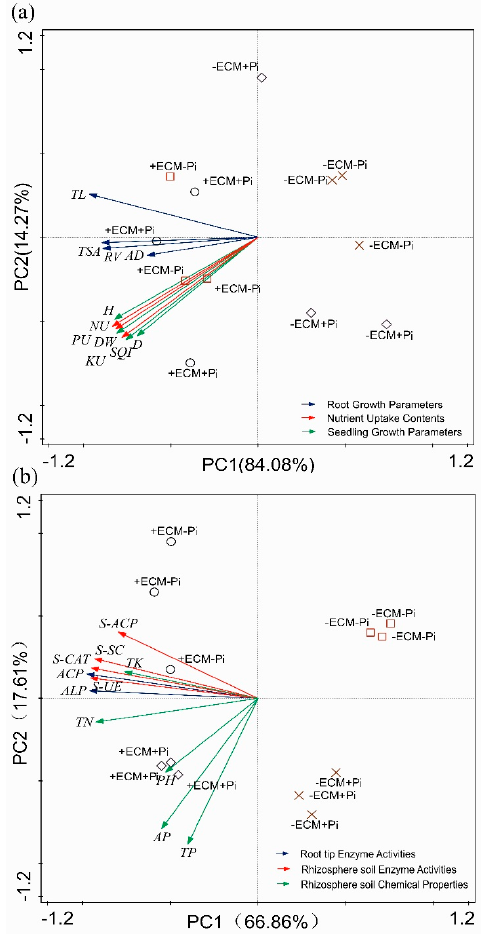
Figure 6. Principal component analysis (PCA) describing the responses of nutrient uptake, and root and seedling growth parameters ( a ), and the root tip enzyme activities, the rhizosphere soil enzyme activities, and chemical properties ( b ). -ECM-Pi: uninoculated and low Pi; -ECM+Pi: uninoculated and high Pi; +ECM-Pi: inoculated and low Pi; +ECM+Pi: inoculated and high Pi; H: height (cm); D: diameter (mm); DW: dry weight (g); SQI: seed quality index; TSA: root total surface area (cm 2 ); TL: root total length (cm); RV: root volume (cm 3 ); AD: root average diameter (mm); NU: whole plant (sum of roots, stems and leaves) N uptake (g ‧ plant − 1 ); PU: whole plant (sum of roots, stems and leaves) P uptake (g ‧ plant − 1 ); KU: whole plant (sum of roots, stems and leaves) K uptake (g ‧ plant − 1 ); ALP: root alkaline phosphatase (U ‧ g − 1 ); ACP: root acid phosphatase (U ‧ g − 1 ); S-ACP: soil acid phosphatase (U ‧ mg − 1 ); S-CAT: soil catalase activity (U ‧ g − 1 ); S-SC: soil sucrase activity (U ‧ g − 1 ); S-UE: soil urease activity (U ‧ g − 1 ); AP: available phosphorus (mg ‧ kg − 1 ); TN: soil total nitrogen (mg ‧ kg − 1 ); TP: soil total phosphorus (mg ‧ kg − 1 ); TK: soil total potassium (mg ‧ kg − 1 ); PH, pH.